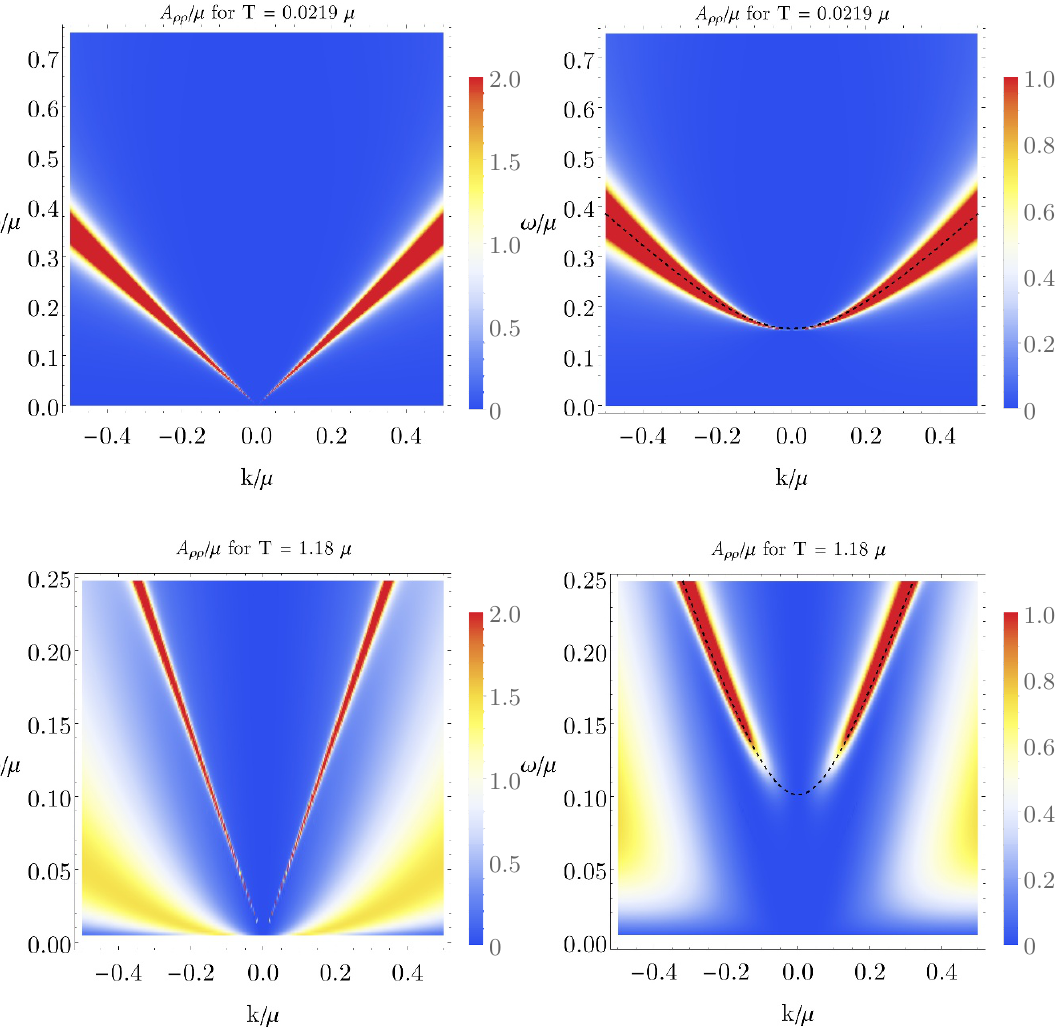
Figure 3. The density spectral function for T ’ 0 : 02 (cid:22) (top) and T ’ 1 : 18 (cid:22) (bottom) without (left) and with (right) double-trace deformation. Here we have taken (cid:11) 2 = 1 = 25. The black dashed line represents the plasmon modes computed in the hydrodynamic approximation. We see that the double-trace deformation turns the low-energy sound modes into a gapped plasmon mode, although the low-energy excitation are less visible as the height of the peak for low j k j =(cid:22) becomes smaller for higher values of T=(cid:22)